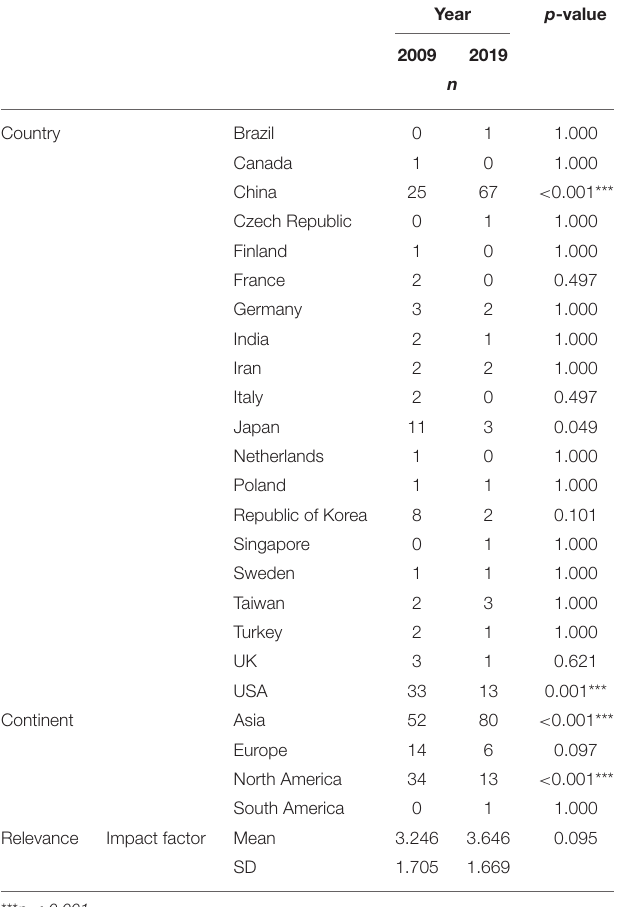
TABLE 5 | Number of studies conducted in a given country and impact factors of the studies included in the